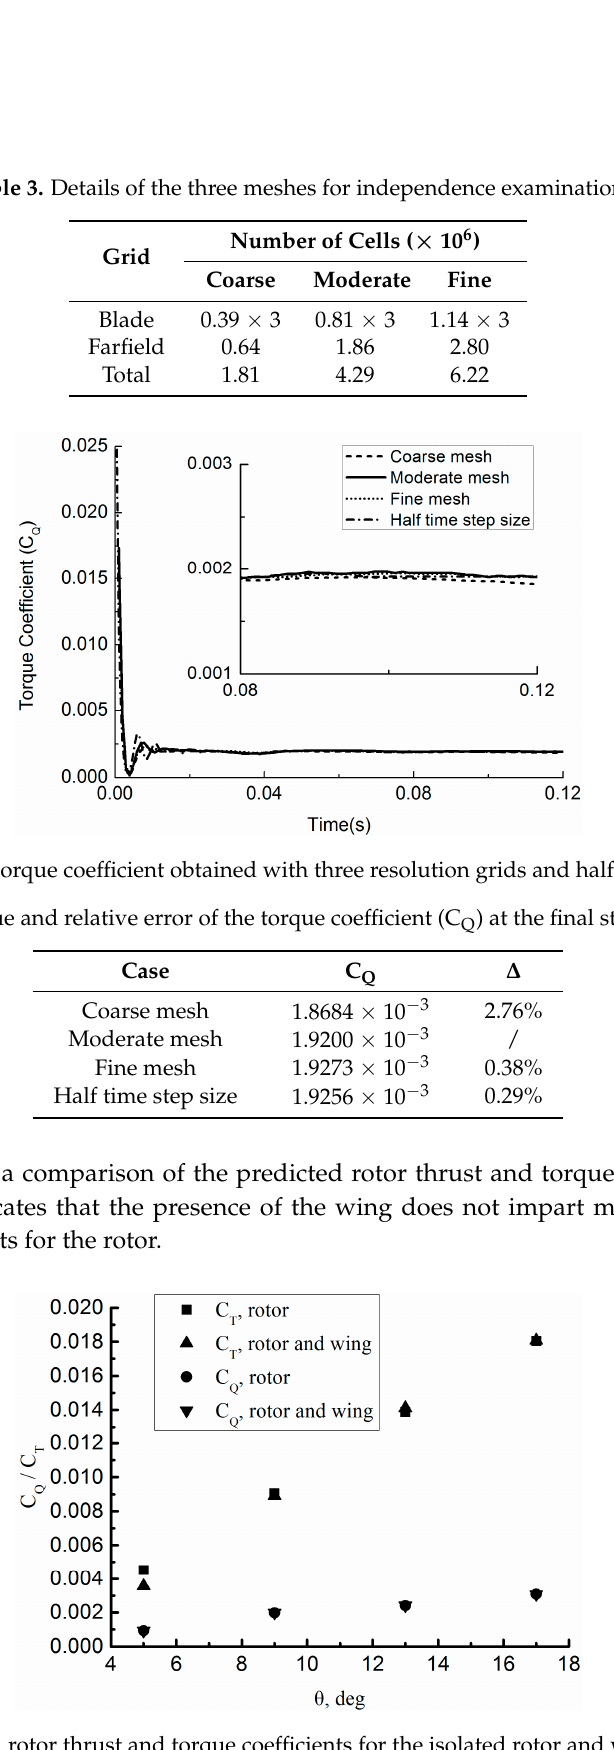
Figure 6. Predicted rotor thrust and torque coefficients for the isolated rotor and wing–rotor cases.